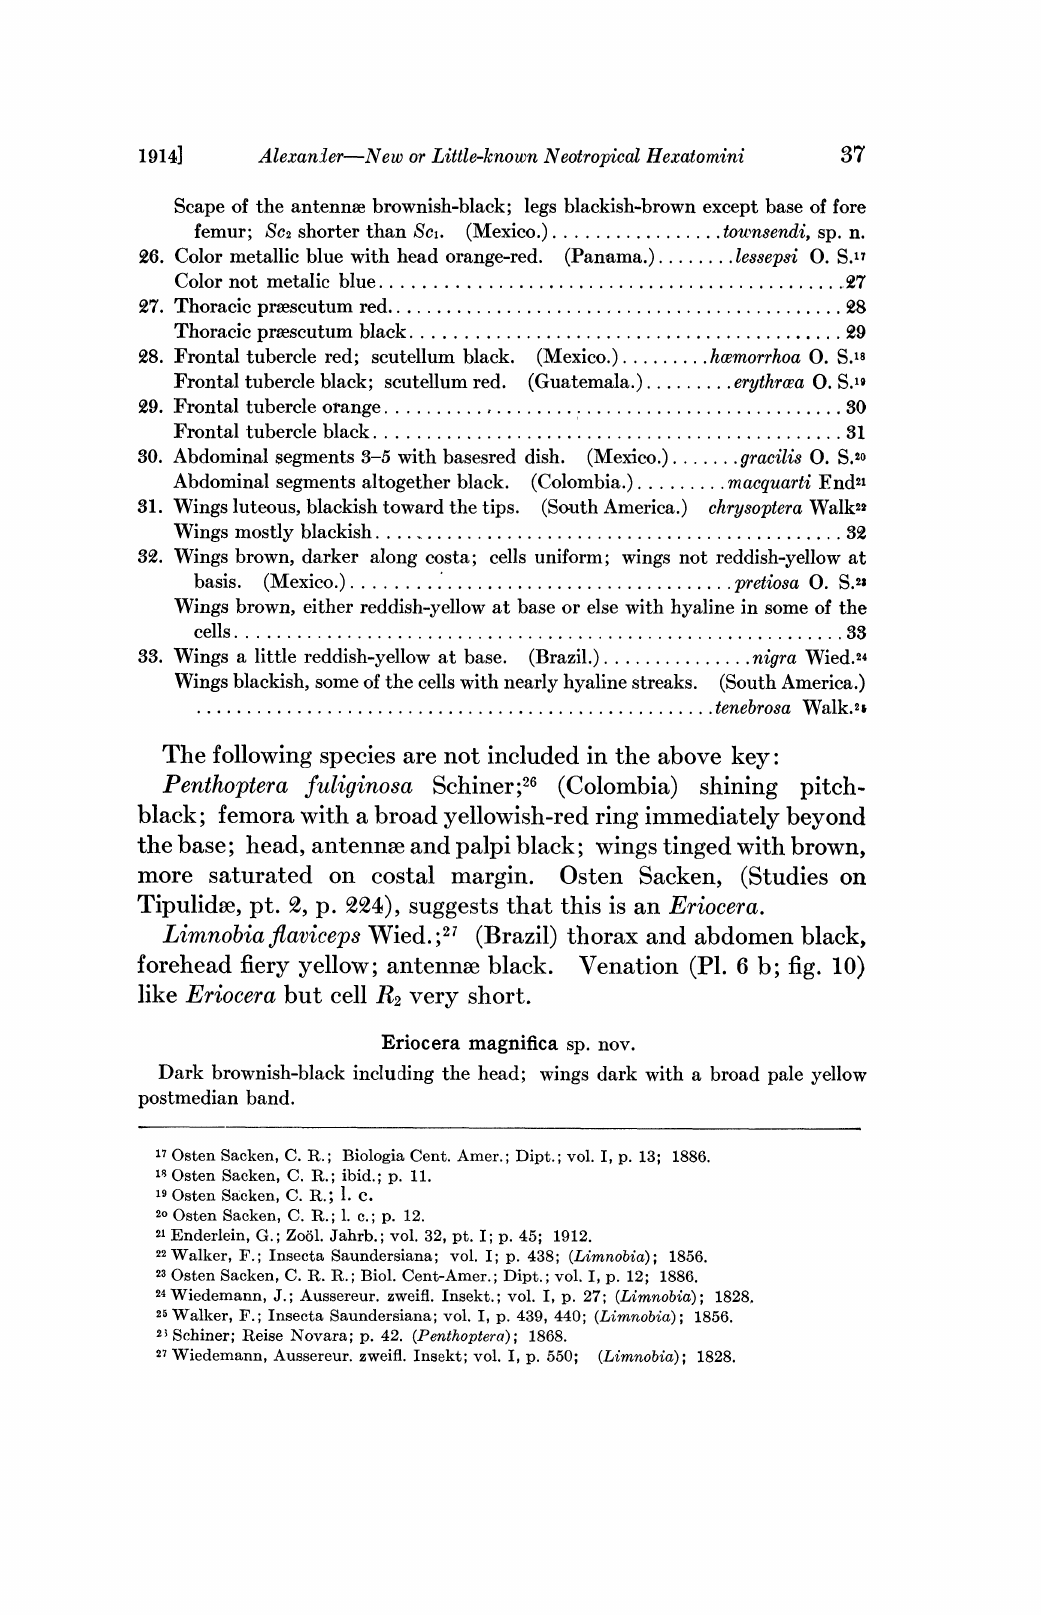
37. Thoracic prescutum red Thoracic prescutum black 39 38. Frontal tubercle red; scutellum black. (Mexico.) hcemorrhoa O. Frontal tubercle black; scutellum red. (Guatemala.) erythra O. S. 39. Frontal tubercle orange Frontal tubercle black 30. Abdominal segments 8-5 with basesred dish. (Mexico.) gracilis O. Abdominal segments altogether black. (Colombia.) acquarti F.ndn 31. Wings luteous, blackish toward the tips. (S(>uth America.) chrysoptera Walk’. Wings mostly blackish 3. Wings brown, darker along costa; cells uniform; wings not reddish-yellow at basis. (Mexico.) pretiosa O. Wings brown, either reddish-yellow at base or else with hyaline in some of the cells 38. Wings a little reddish-yellow at base. (Brazil.) nigra Wied.4 Wings blackish, some of the cells with nearly hyaline streaks. (South America.)